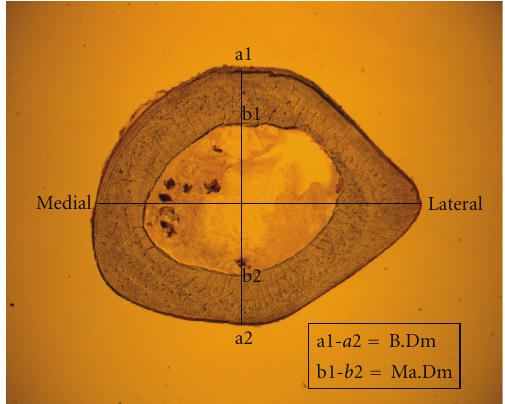
Figure 2: Cortical bone analysis. The figure shows the trochanteric cross section of proximal femur of Sprague-Dawley rat, cut 15mm distal from the capitis femoris. We measured the bone diameter (B.DM) and the marrow diameter (Ma.Dm) on the ventrodorsal axis (the line perpendicular to the middle of the mediolateral axis) of the cross